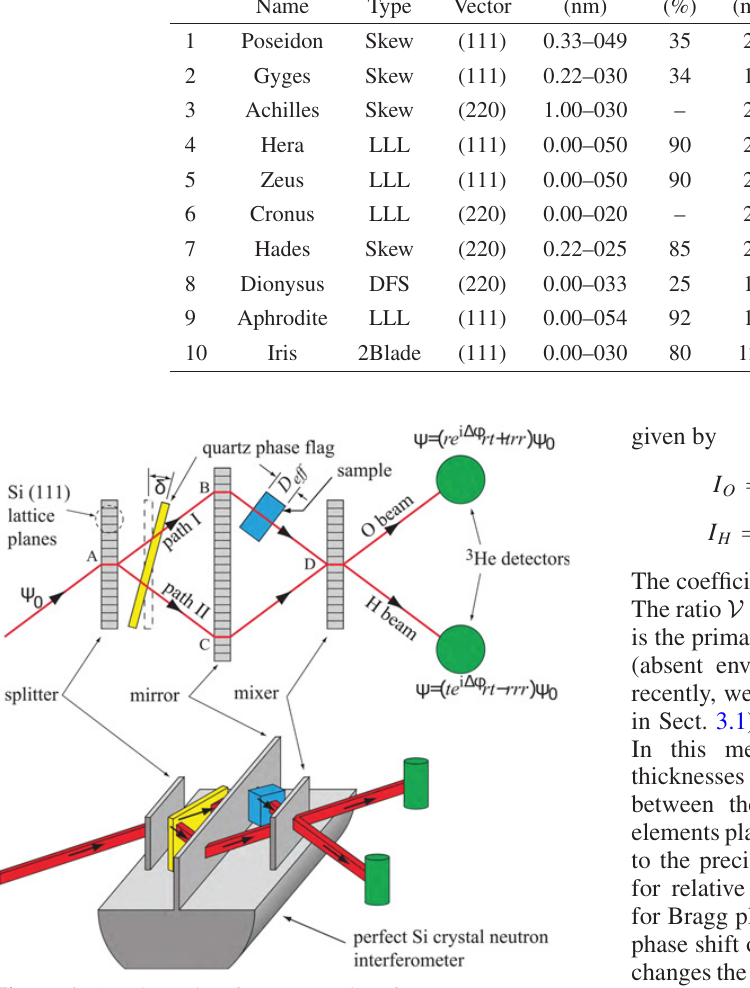
Figure 1. A schematic of a neutron interferometer. Neutrons incident on a crystal blade are Bragg diffracted into two spatially separated paths. These paths interfere with each other in the third or final blade of the interferometer and are detected using two 3 He detectors. Differences along the paths modulate the relative intensities of the two